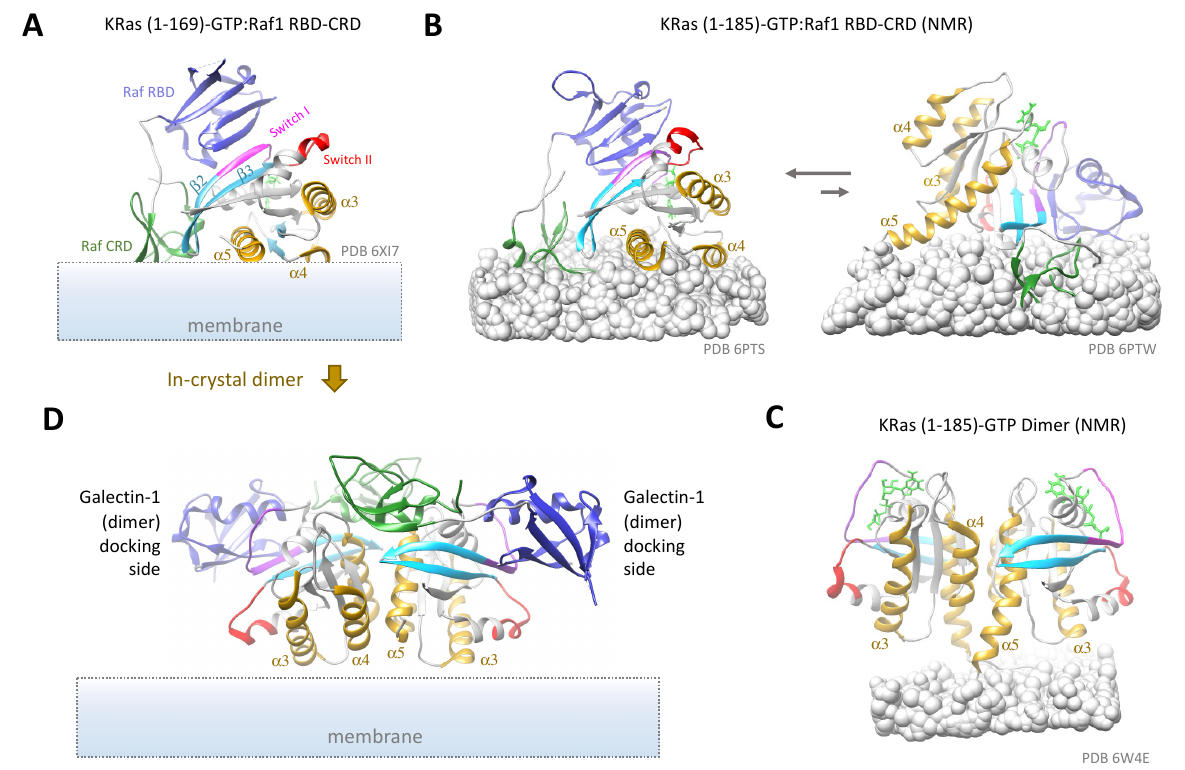
Figure 7. Ras conformations in complexes with binding partners. ( A ) Crystal structure of GTP-bound KRas G-domain in complex with Raf1 RBD-CRD, showing its orientations in approximation with membrane modeled in, as in ref [197]. ( B ) NMR structures of full length KRas-GTP in complex with Raf1 RBD-CRD, showing two different conformations of the complex relative to the nanodisc membrane (rendered as gray balls), with the left conformation being dominant at low complex concentrations. ( C ) NMR structure of full length KRas-GTP dimer on nanodiscs. ( D ) Potential dimer configuration present in the crystal structure of (A) (PDB 6XI7), as proposed by Cookis et al. [200]. The two Raf1 RBDs (blue) could serve as docking sites for Galectin-1 dimers, leading to formation of Ras nanoclusters [115]. The different proteins domains and motifs are labeled the same way as in ( A ). The HVRs in ( B , C ) are either partially buried in or visually blocked by the membrane.